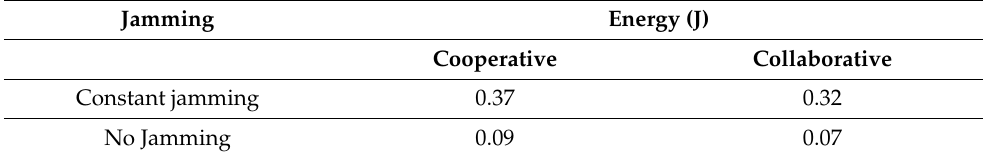
Table 9. Jamming experiment results. Data obtained from [107].